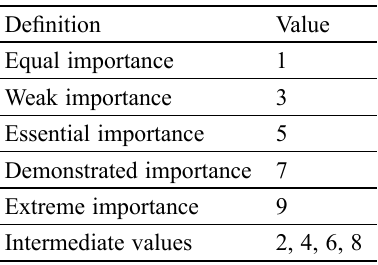
Table 1. Pair-wise comparison